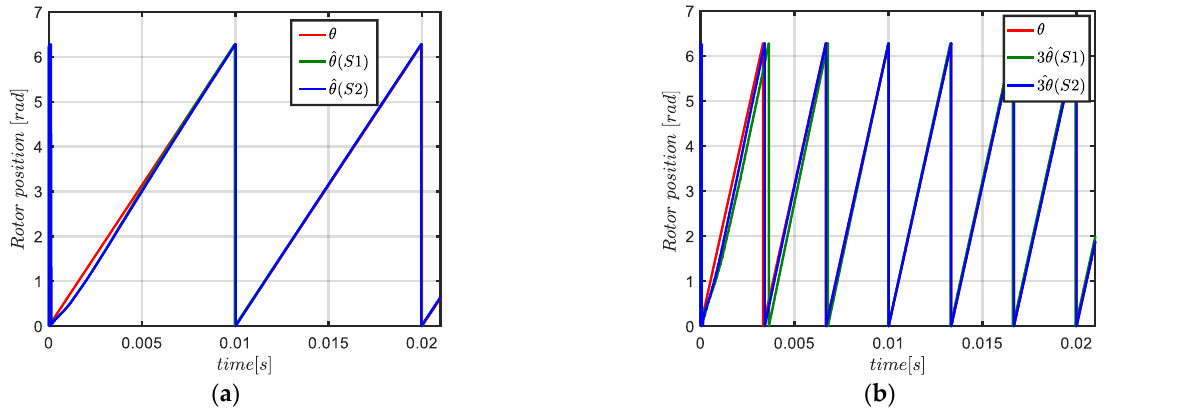
Figure 20. Simulation waveforms at 78 rad/s of actual and estimated rotor position with ( S1 ) and ( S2 ): ( a ) angle required to control MM, ( b ) angle required to control SM. Table 4. Resulting position error (electrical angle) from strategies ( S1 ) and ( S2 ) .